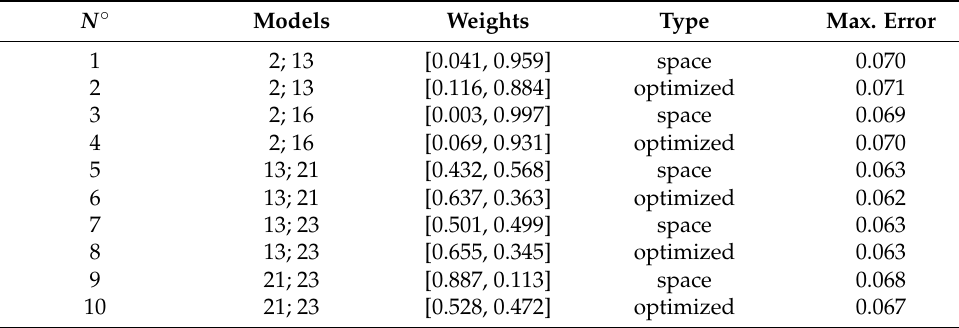
Table 10. Ensemble models tested using two single models and the maximum error obtained. N ◦ Models Weights